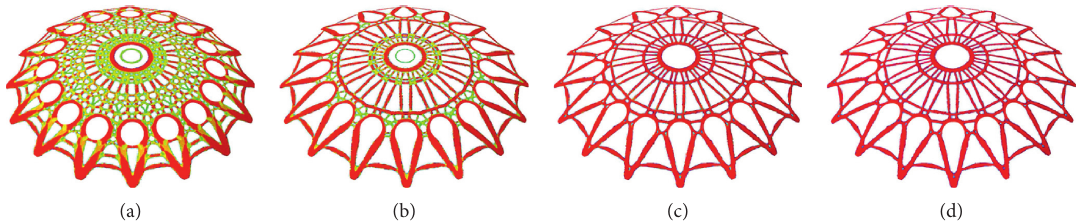
Figure 7: Optimization results of a spherical shell with predefined holes (isometric view). (a) 40 th iteration. (b) 60 th iteration. (c) 80 th iteration. (d) 95 th